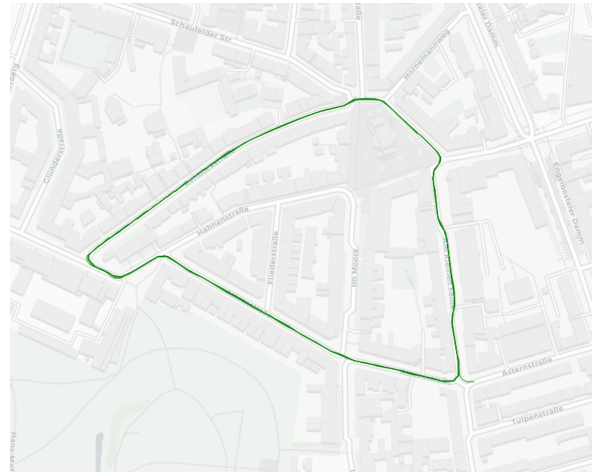
Figure 6. Trajectory of measurement experiment (background map: OpenStreetMap (OpenStreetMap contributors,